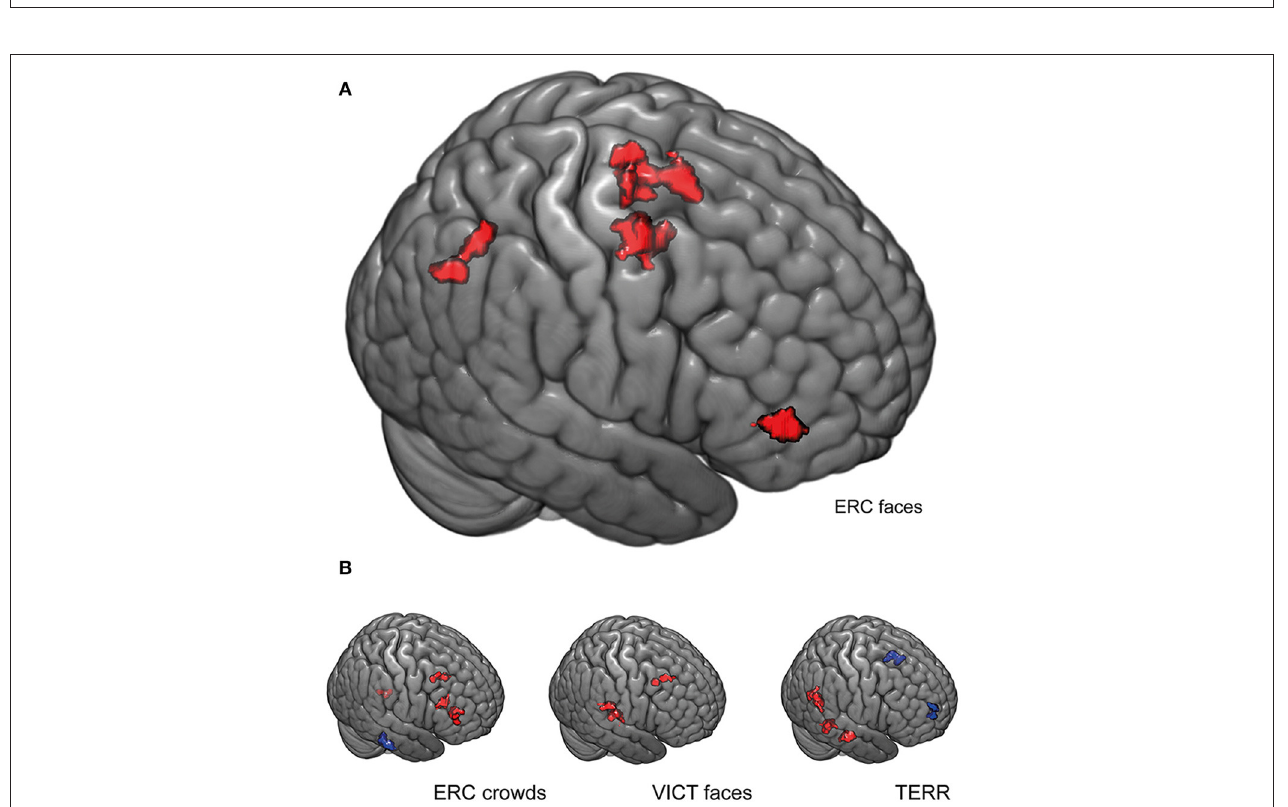
FIGURE 7 | Functional connectivity (FC) analysis of the left fusiform gyrus. (A) For the ERC FACES condition, differences were observed between HX and LX subjects in the functional connectivity of the left fusiform gyrus seed (functional cluster of the left FG; FWE p ≤ 0.05, 96 voxels, local maxima x, y, z = − 36, − 58, − 16). The FC is higher among HX subjects for the right middle frontal gyrus, the left supplementary motor area, and the precuneus. This ERC FACES-specific pattern of the FG FC differed from the patterns observed for the other conditions shown in (B) . For each condition the color red indicates increased functional connectivity (with the left FG seed) among HX subjects compared to LX subjects, and the color blue indicates increased FC among LX subjects compared to HX subjects ( p ≤ 0.05 FWE–corrected). The bar shows the image intensity brightness range from 0 to 0.5. ERC FACES: European refugee crisis with a close-up of emotional faces; ERC crowds: European refugee crisis showing an anonymous crowd; TERR: Islamic terrorists in a threatening pose; VICT FACES: victims of natural disasters or accidents with a close-up of emotional faces. Clusters are rendered on an MNI template using MRIcroGL (https://www.nitrc.org/projects/mricrogl/).